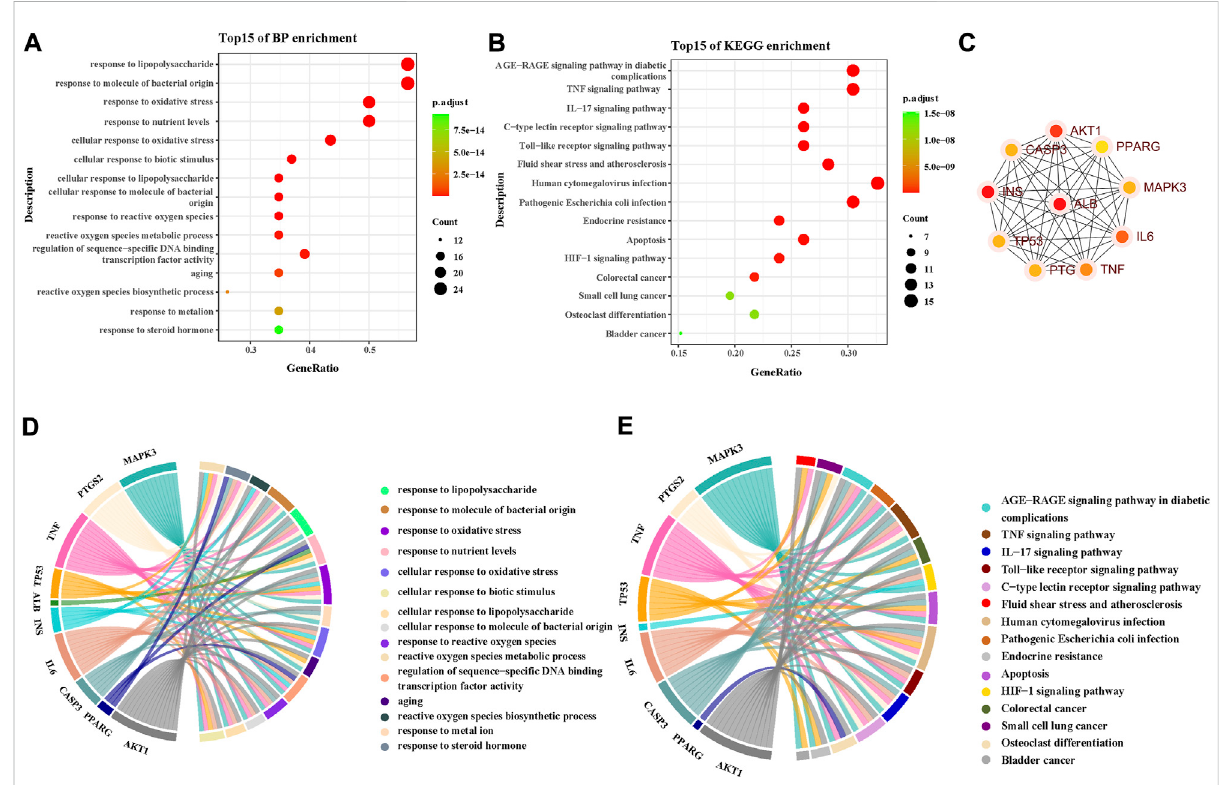
FIGURE 5 GO and KEGG pathway enrichment analyses. (A) Top 15 signi fi cantly rich GO analyses for the biological function of potential target genes of YFBP in CRC. (B) KEGG analysis of the fi rst 15 signi fi cantly abundant YFBP potential target gene signaling pathways in CRC. (C) Top 15 vital signaling pathways ’ core network. (D) Correlation between the core network and the top 15 signi fi cantly abundant gene biological function catalogs. (E) Correlation between the core network and the top 15 vital signaling